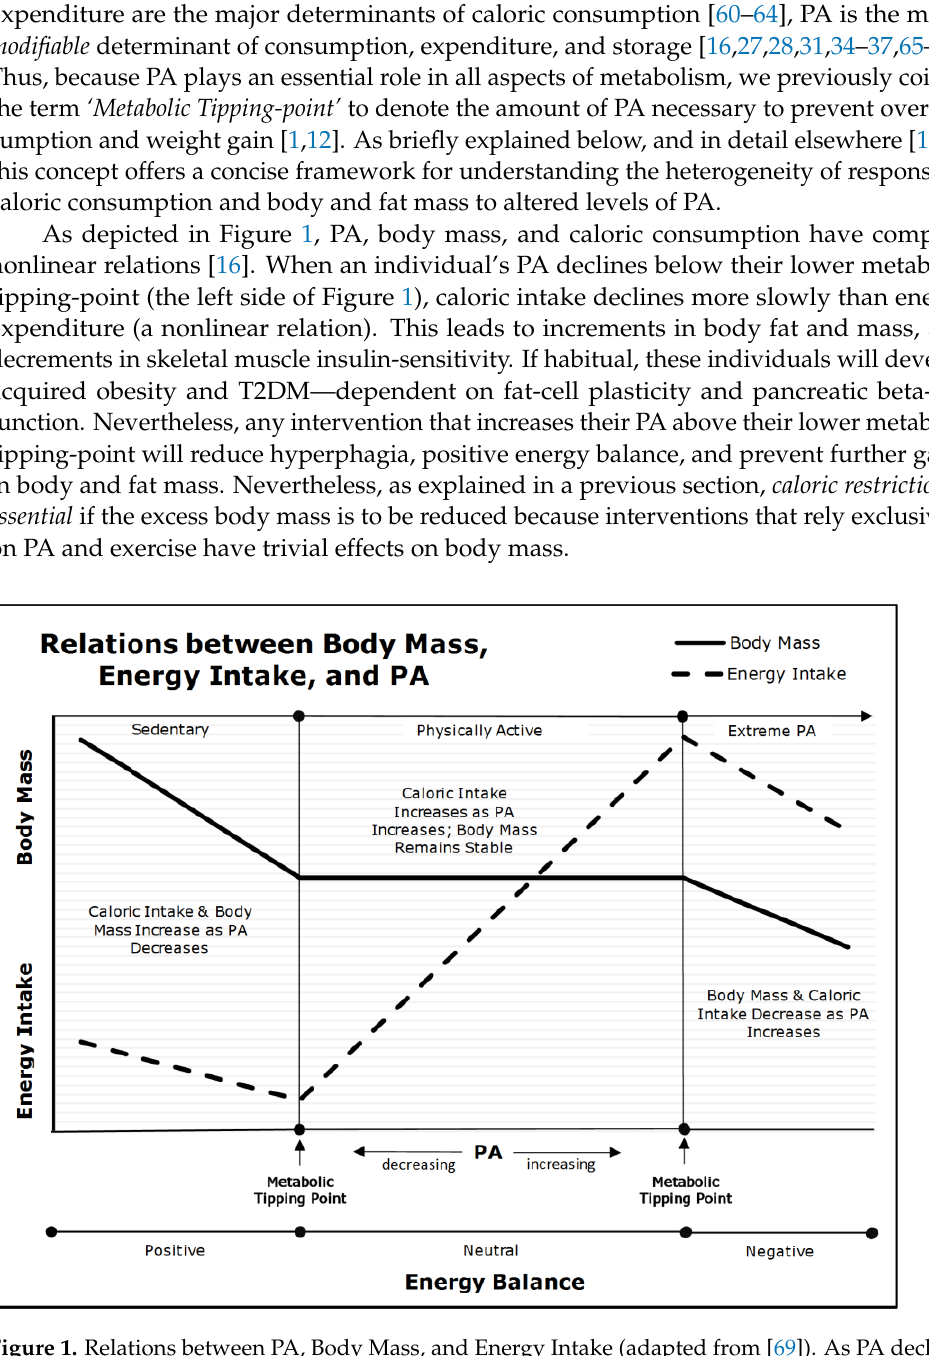
Figure 1. Relations between PA, Body Mass, and Energy Intake (adapted from [69]). As PA declines below the lower metabolic tipping-point into the ‘Sedentary’ range (left panel), energy intake and energy expenditure become dissociated due to insufficient PA. Body mass begins to increase as energy balance becomes positive and insulin sensitivity is diminished.